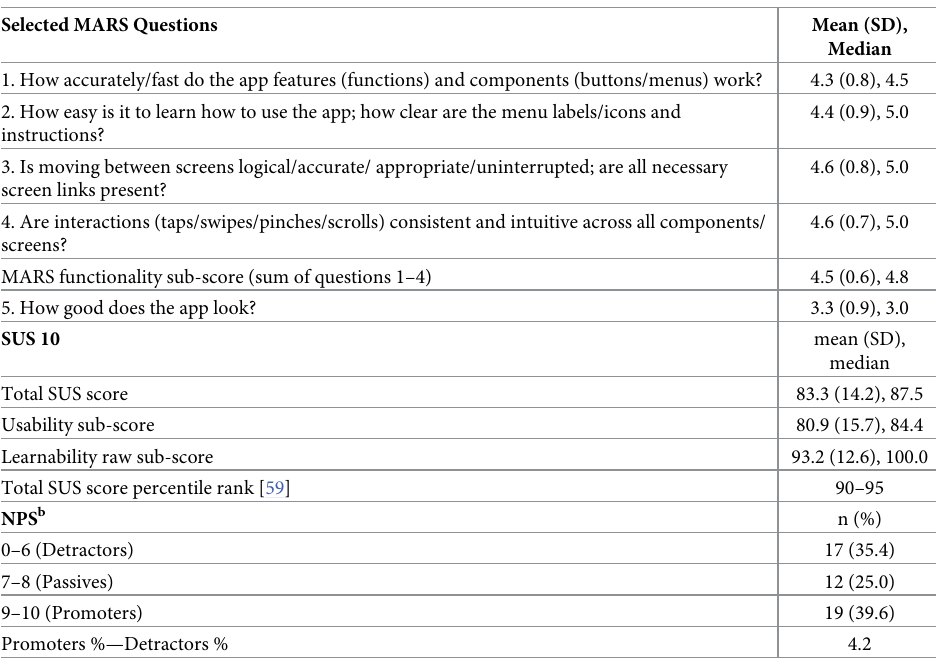
Table 3. Summary of the end of study in-app ratings a (n = 50). Selected MARS